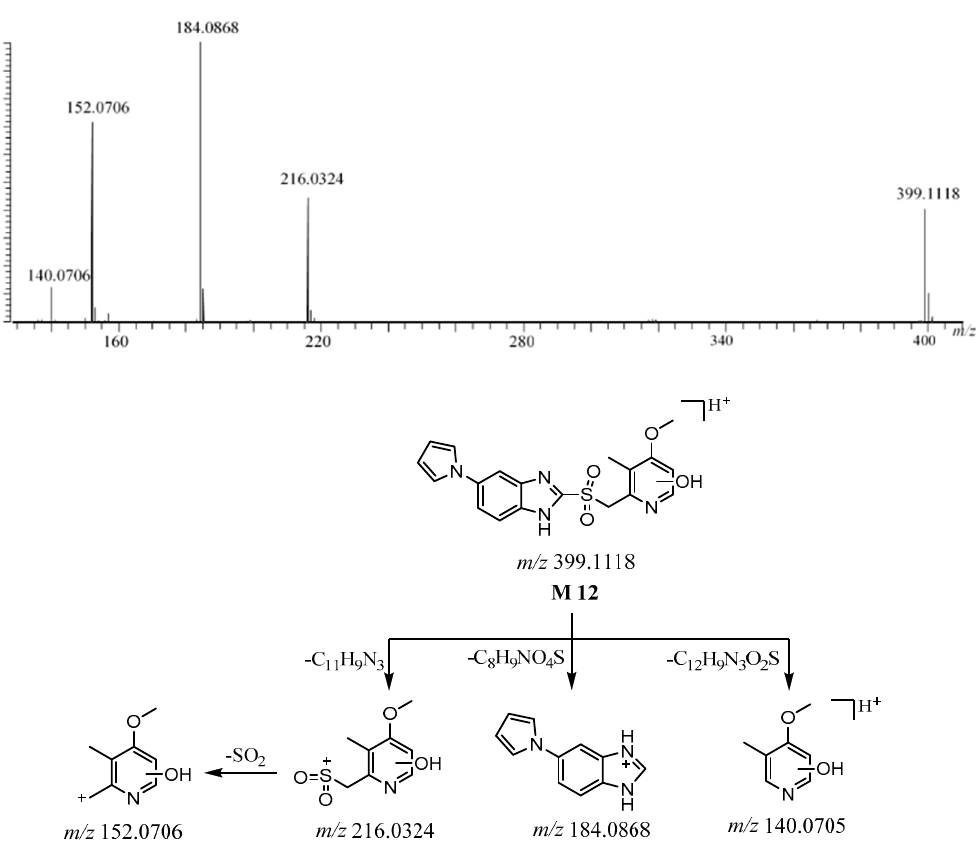
Figure 11. The HRMS/MS spectrum and the possible fragmentation pathway of M12 .